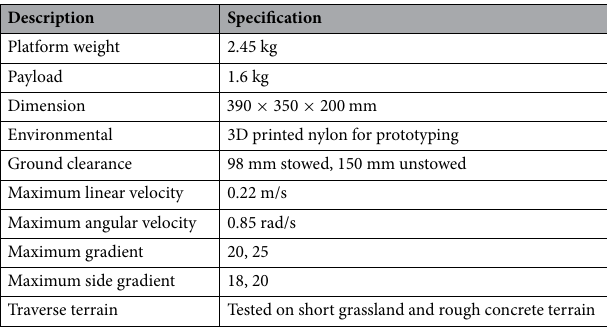
Table 2. Technical specifications of Raptor.